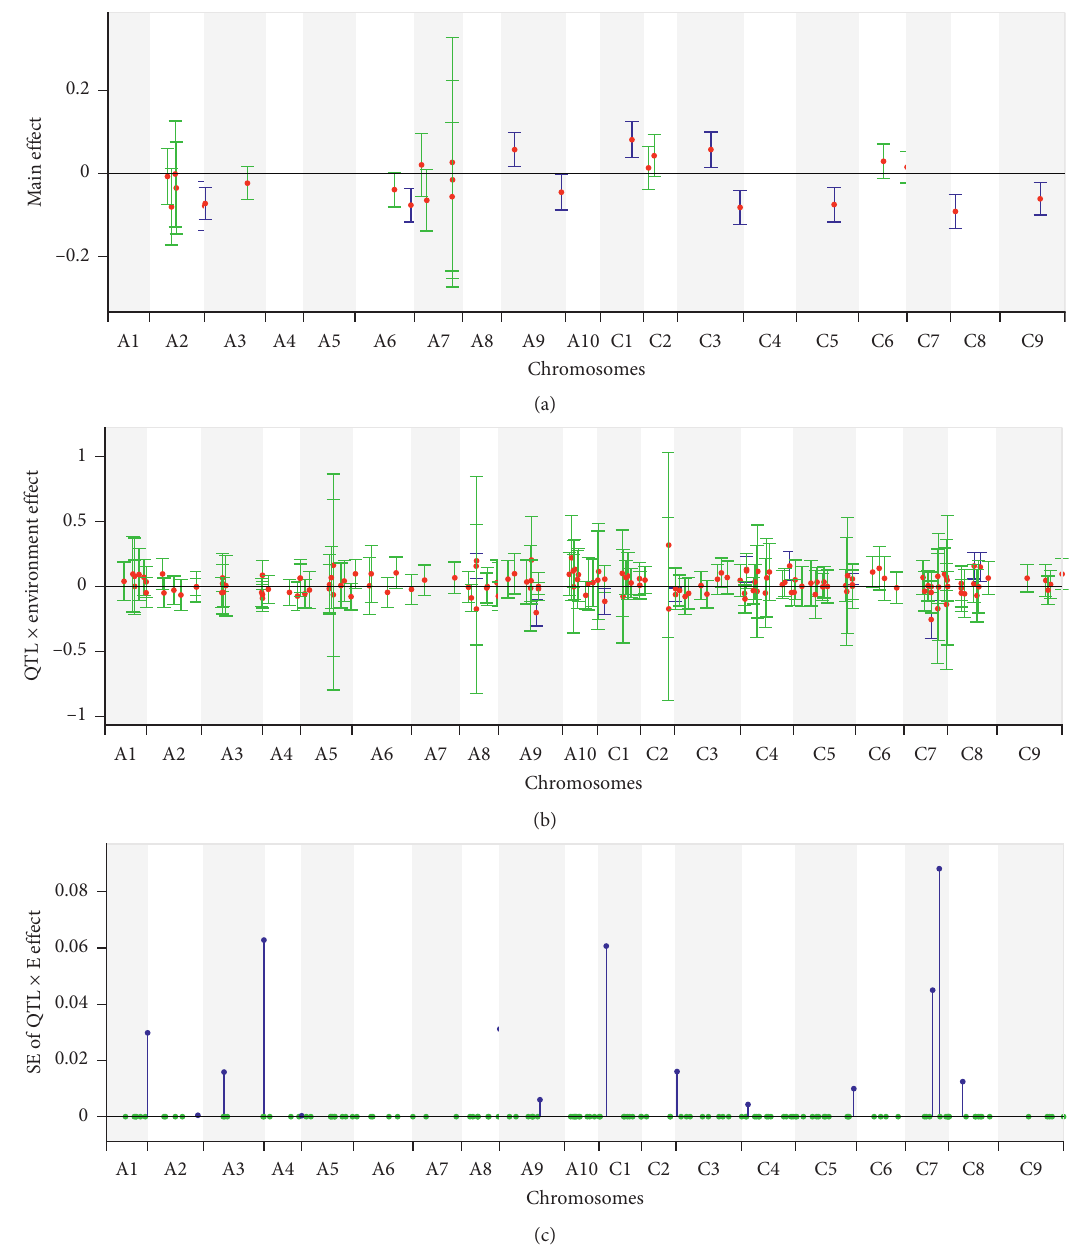
Figure 3: The point estimates and 95% confidence intervals (95% CI) for marker main and environment-specific effects and the standard error (SE) of environment-specific effects for SY. (a) Point estimates (red dots) and 95% CI for main effects (the vertical blue and green CIs represent statistically significant or nonsignificant values, respectively). (b) Point estimates (red dots) and 95% CI for environment-specific effects (the vertical blue and green CIs represent statistically significant or nonsignificant values, respectively). (c) SE for environment- specific effects (the blue and green stems represent environment-specific effects found in multiple environments or only one environment,